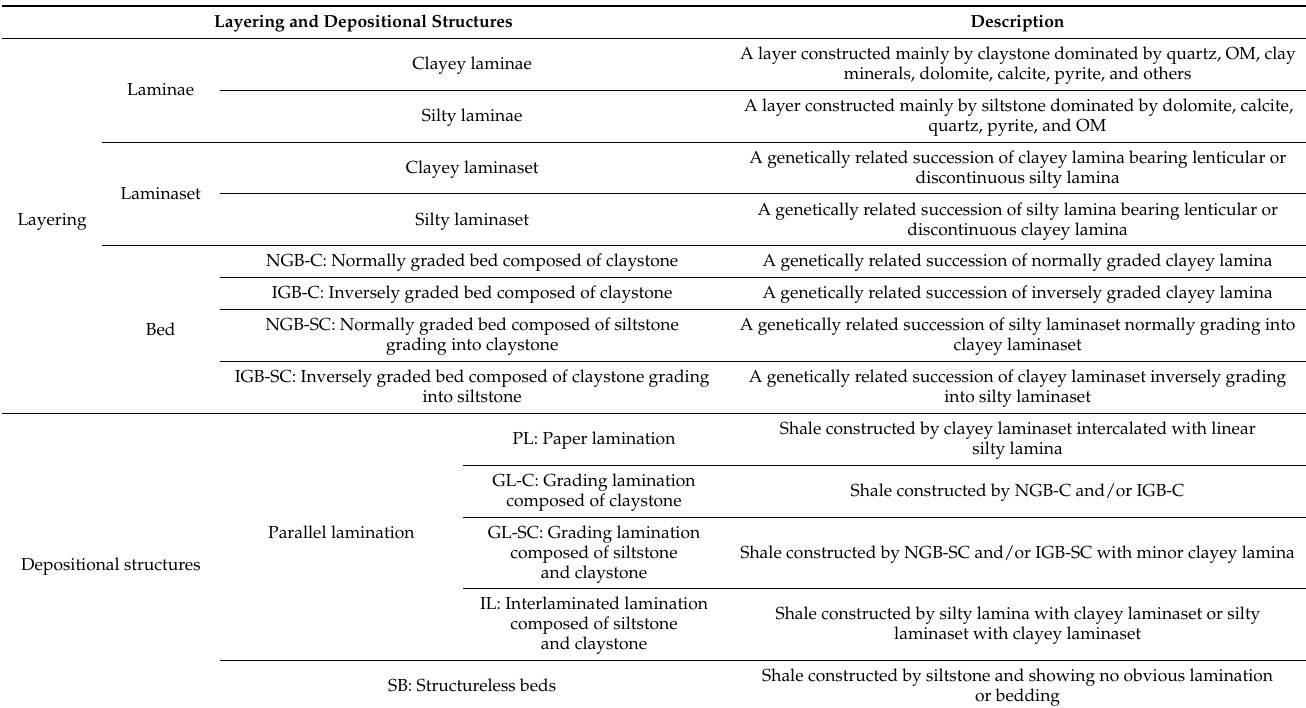
Table 1. Sampling cores and outcrop from the Wufeng–Longmaxi shale in the Sichuan Basin of southwestern China. In the Table, LTS is for large thin section, STS is for standard thin section, TOC is for total organic carbon, XRD is for X-ray diffraction whole rock, PP is for porosity and permeability, MTEA is for main and trace element analysis, and FE-SEM is for field-emission scanning electron